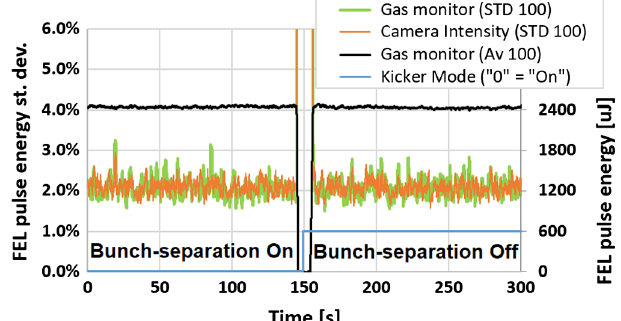
FIG. 19. FEL photon beam pulse energy (running average of 100 consecutive pulses) measured by the gas-based monitor and its running standard deviation of 100 consecutive pulses mea- sured with gas-based monitor and photon beam image camera with the bunch-separation system on and off.